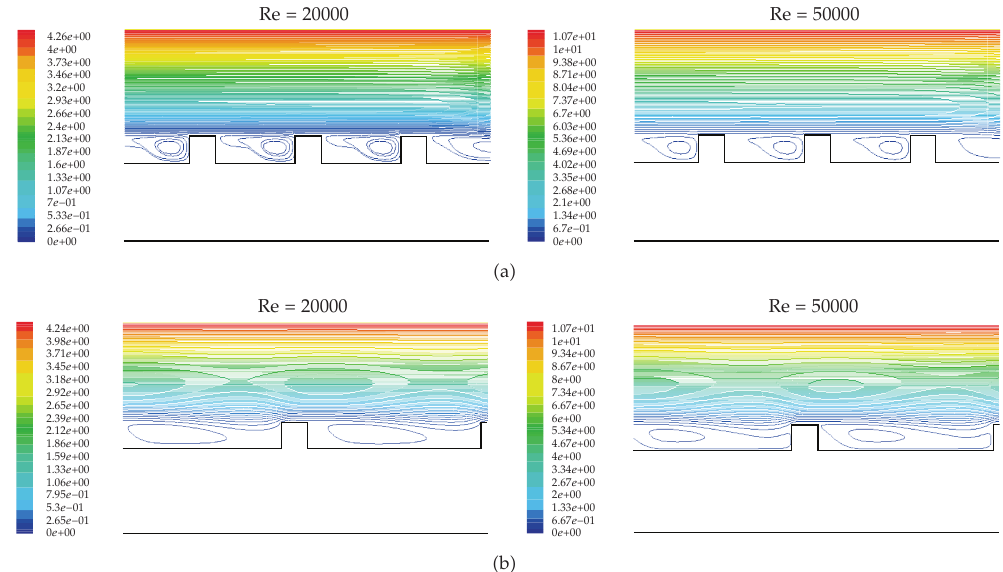
Figure 12: Stream function contours at Re (cid:8) 20000 and 50000, for square-ribs, e/d (cid:8) 0 . 05: (cid:6) a (cid:7) p/e (cid:8) 4 and (cid:6) b (cid:7) p/e (cid:8)